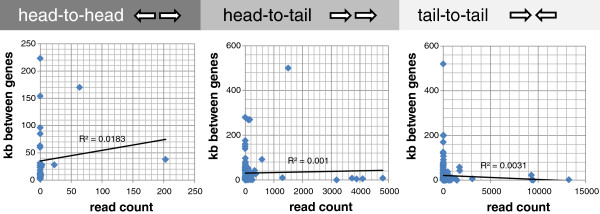
Scatter plot of endo-siRNA read count versus distance to the neighboring gene. Left panel, genes arranged head to head (divergent transcription); middle, genes in tail to head orientation; right panel, genes in tail to tail arrangement (convergent transcription). The R2 values indicate a lack of correlation in all three panels.